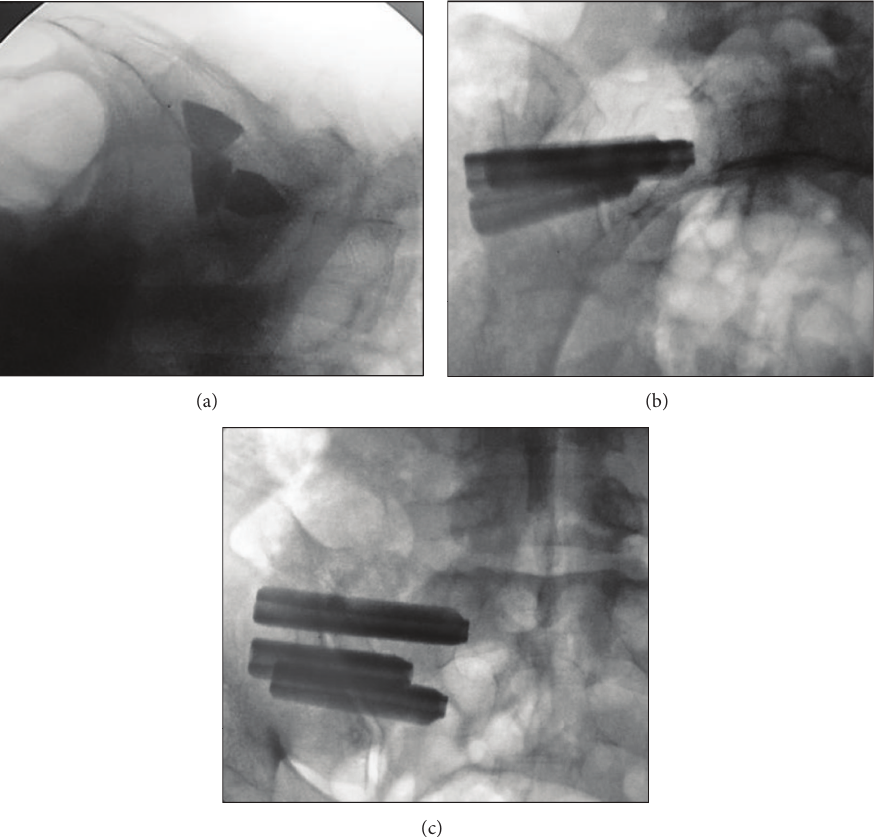
Figure 4: Lateral (a), inlet (b), and outlet (c) views of final implant placement through the ilium, across the sacroiliac joint, and into the sacrum, representing safe implant placement as measured via continuous passive EMG monitoring and